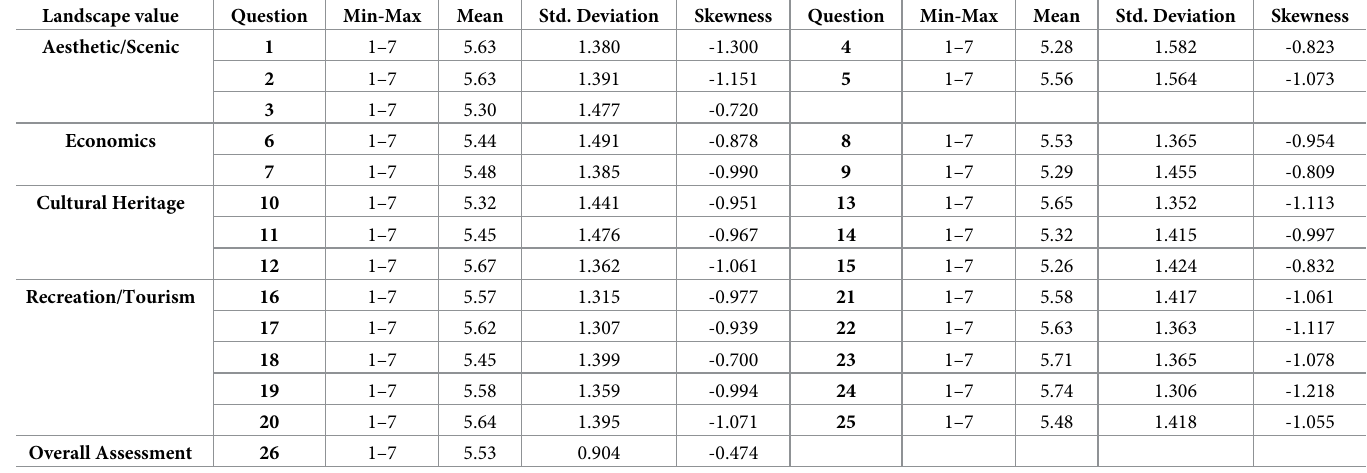
Table 3. Descriptive statistics of stakeholder